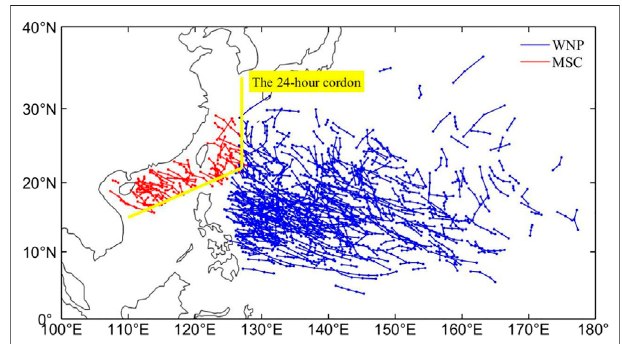
intensi fi cation (RI) cases during 1980 – 2018. The red tracks are RI TC cases overtheMSC,andthebluearethoseovertheWNP.Theyellowlineisthe 24-h cordon, which distinguishes the MSC and the WNP.